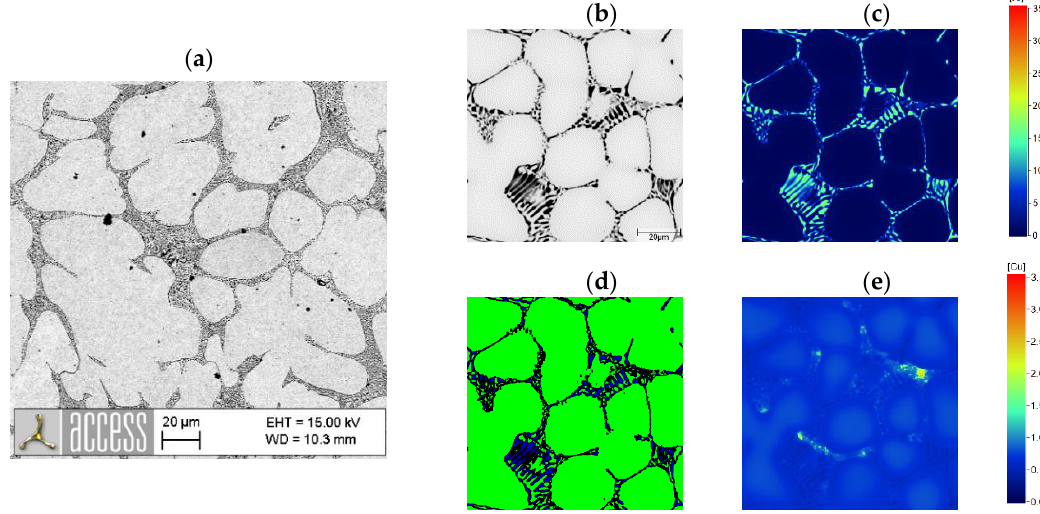
Figure 4. ( a ) Microstructure of ZnAl2Cu0.7 in backscattered electrons (BSE) contrast; ( b – e ) simulated microstructure of ZnAl2Cu0.7. ( b ) Al (gray scale, matched contrast), ( c ) Al concentration (wt.%), ( d ) phases (η green, β blue) and ( e ) Cu concentration (wt.%). Size of the 2D plane from the simulation: 100 µm × 100 µm.